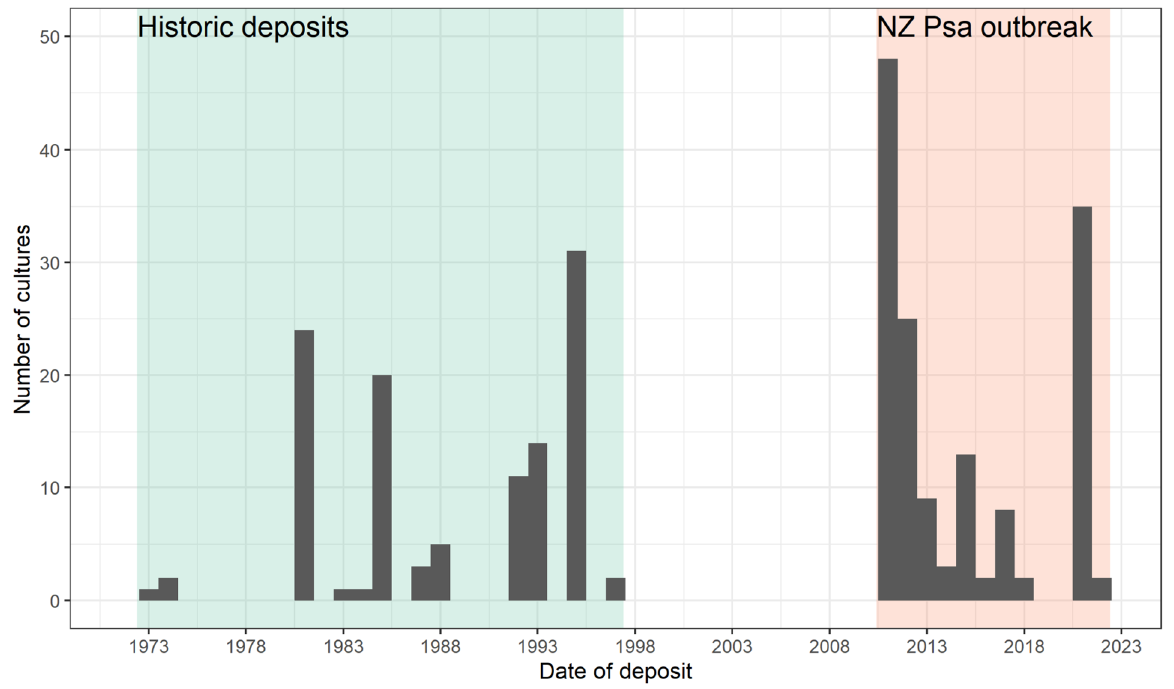
Figure 2. Deposits of Pseudomonas cultures isolated from New Zealand kiwifruit in the ICMP culture collection. A 13-year gap in deposits before the 2010 outbreak limited the use of the collection in determining the timeline of the origin of the incursion. Table 1. The changing nomenclature of global populations of P. syringae pv. actinidiae. Population [23]